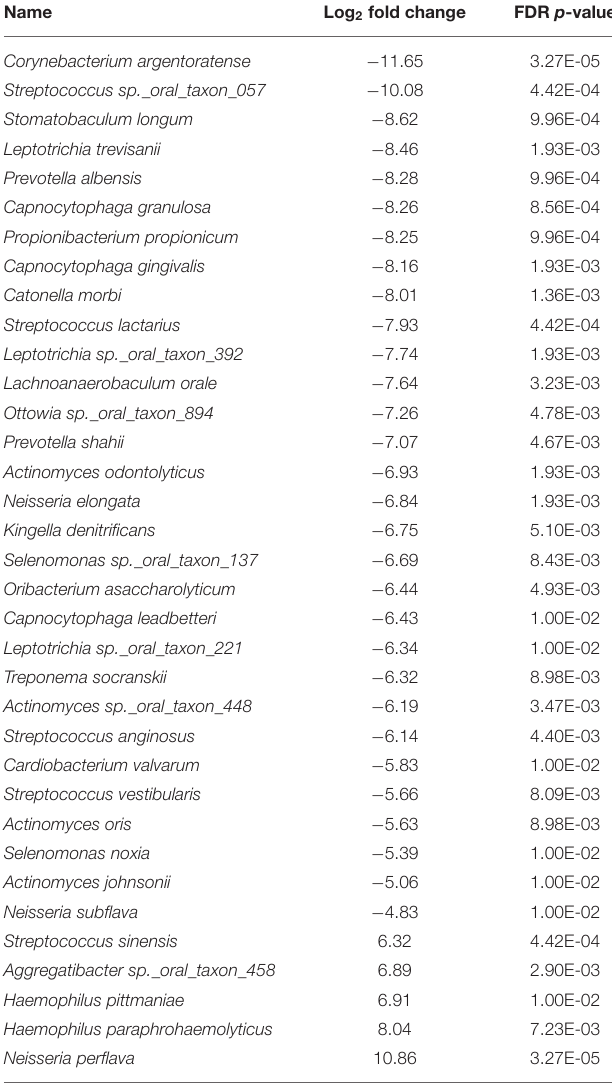
TABLE 4 | Bacteria sensitive to salivary SP-A